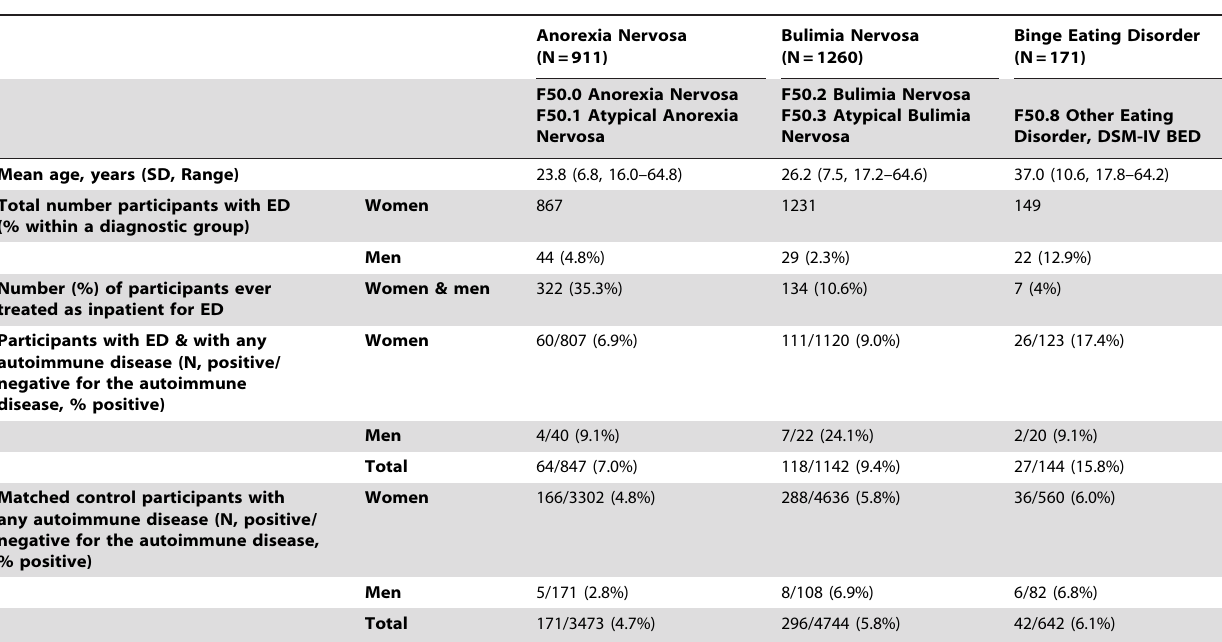
Table 1. Study sample by diagnostic groups with lifetime prevalence figures of autoimmune diseases covering the time before, during, and after the treatment for an eating